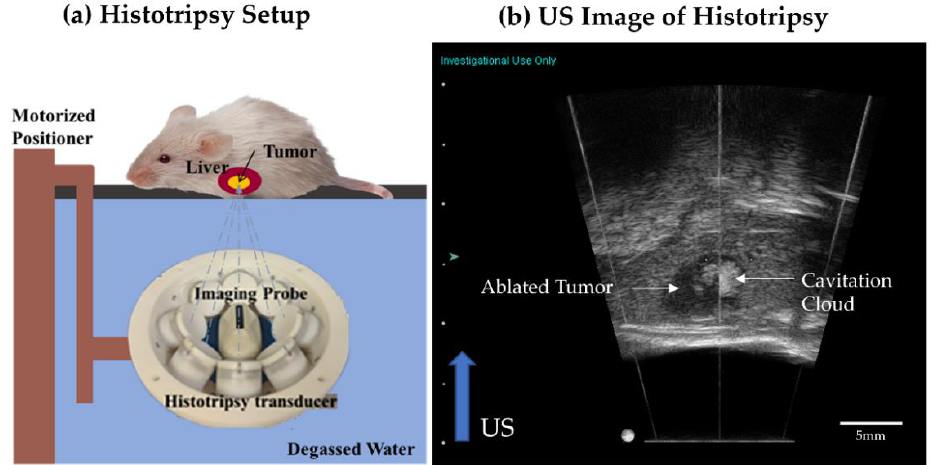
Figure 1. ( a ) The rodent histotripsy treatment setup consisted of an 8 element 1 MHz therapy transducer delivering 1–2 cycle pulses at P– 30 MPa and 100 Hz PRF. A coaxially aligned 20 MHz imaging probe was used for real-time ultrasound guidance. Both transducers were mounted to a motorized positioning system and immersed in a tank of degassed water (coupling medium). The animal was placed in a prone position on a platform to allow the intended target region to submerge. ( b ) Generation of hyperechoic cavitation cloud in liver tumor. The ablated tumor region appears hypoechoic compared to surrounding liver parenchyma.